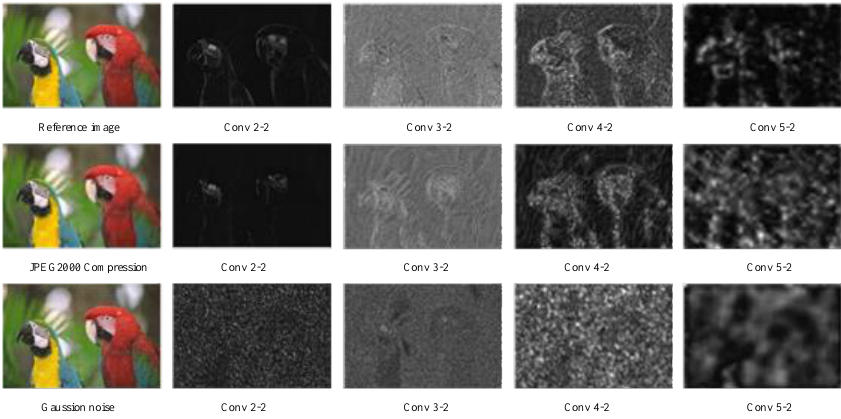
Figure 2. A comparison of several distortion types identified by Sub-Network I.